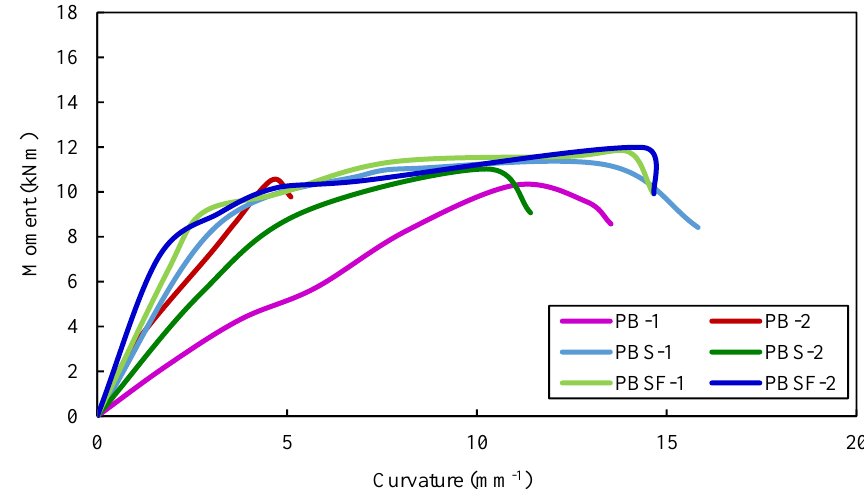
Figure 12. Moment–curvature curves of the plain CFS beams. Figure 12. Moment – curvature curves of the plain CFS beams.